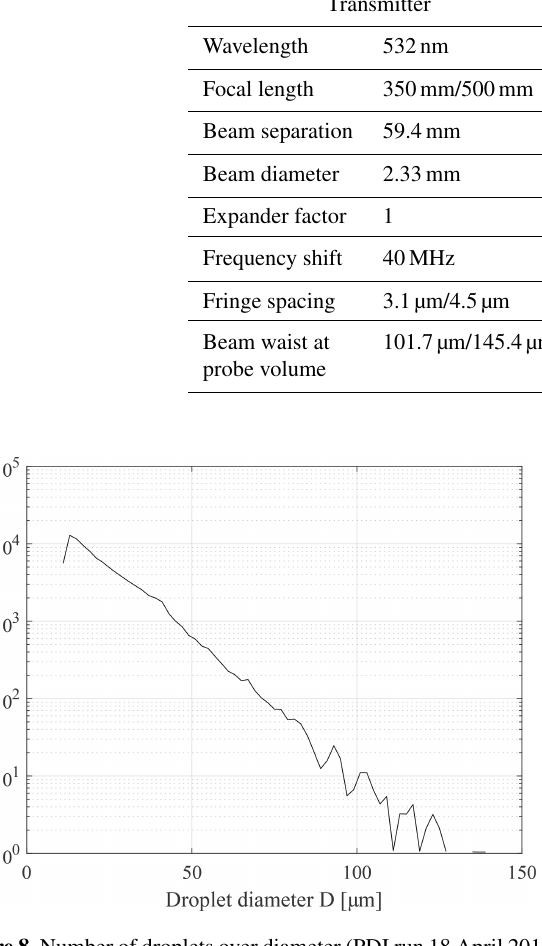
Figure 8. Number of droplets over diameter (PDI run 18 April 2019 18:25LT), total number of counts >